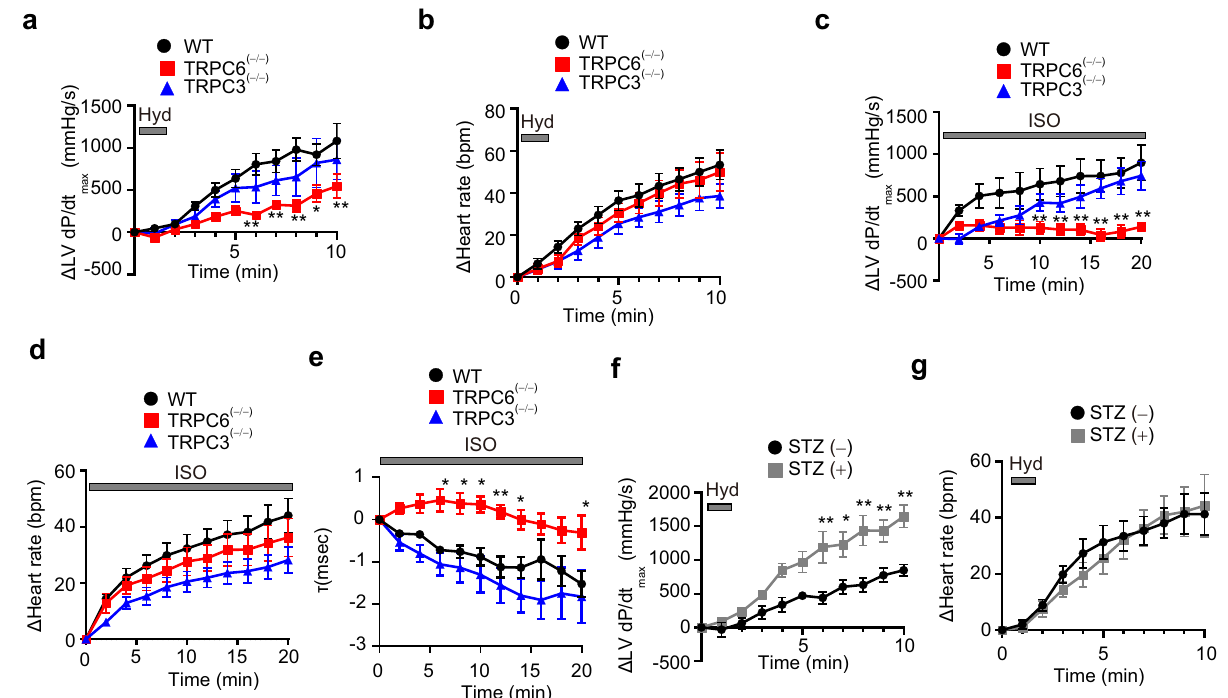
Fig.1|DeletionofTRPC6reducespositiveinotropiceffectsinmousehearts.a, b Mice(129/Sv)wereinjectedwithhydralazine(Hyd;0.5mg/kg,1.2mL/h, i.v .).Time courses of increases in LV Δ dP/dt max ( a ) and Δ heart rate ( b ) induced by hydra- lazine administration (WT, n =9; TRPC6 ( − / − ) , n =5; TRPC3 ( − / − ) , n =5); P =0.0019 (6min), 0.0092 (7min), 0.0005 (8min), 0.0231 (9min), 0.0064 (10min) in ( a ). Time courses of increases in LV Δ dP/dt max ( c ), Δ heart rate ( d ) and LV relaxation time τ ( e ) induced by β AR stimulation ( n =6 each group); P =0.0099 (10min), 0.0034 (12min), 0.0010 (14min), 0.0003 (16min), 0.0003 (18min), <0.0001